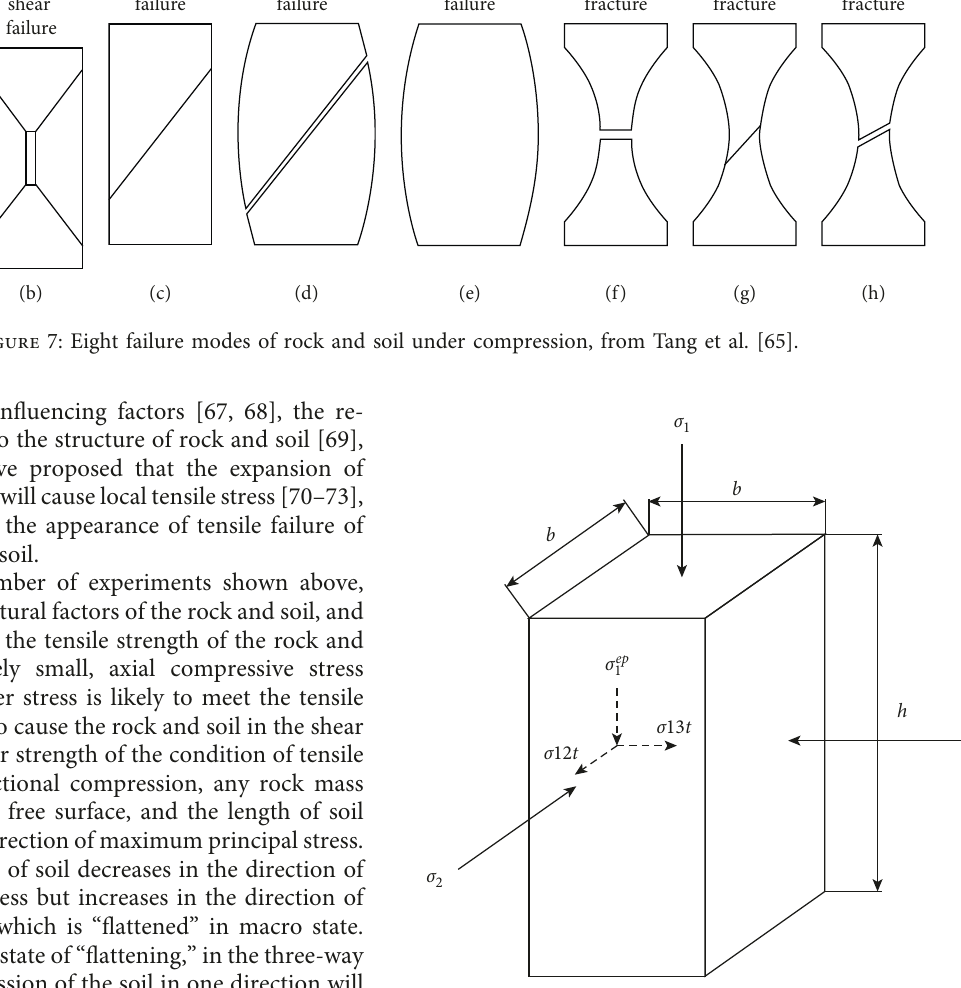
Figure 8: Square column soil under pressure, from Tang et al.